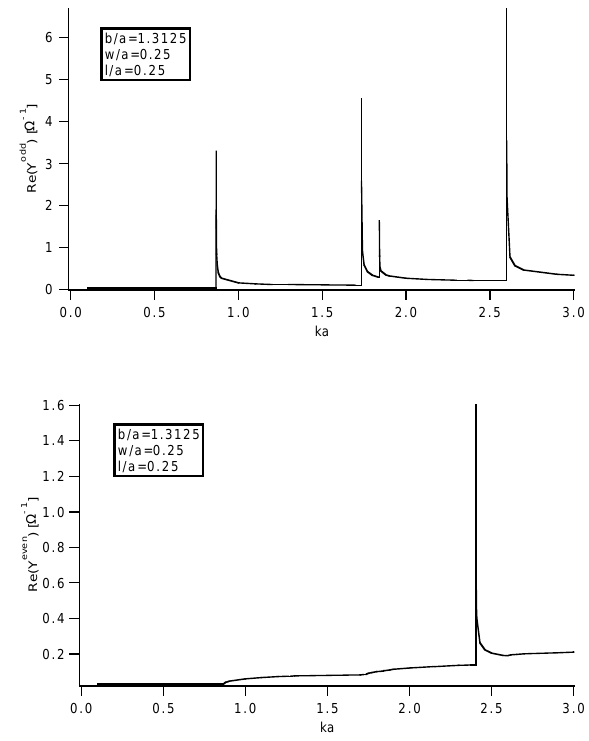
FIG. 4. Real part of the admittance near the cutoff frequencies.